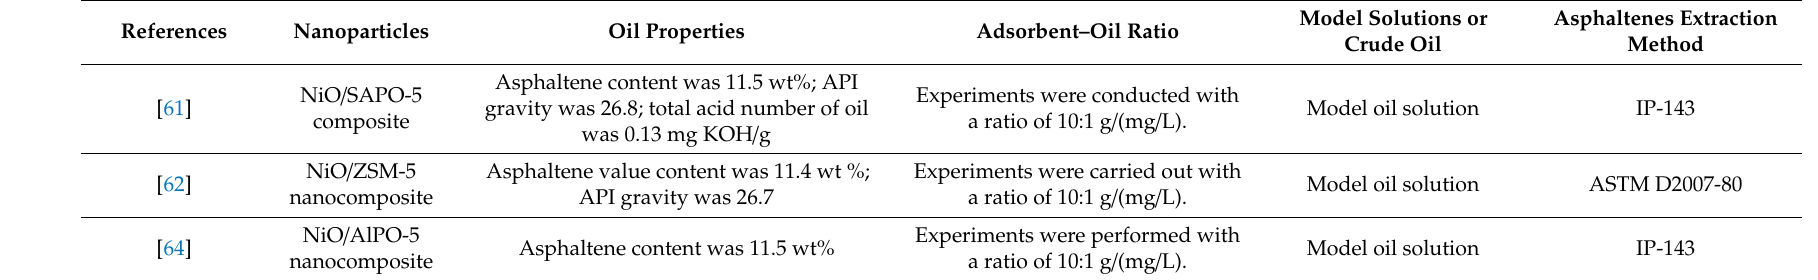
Table 2. Summary of experiments